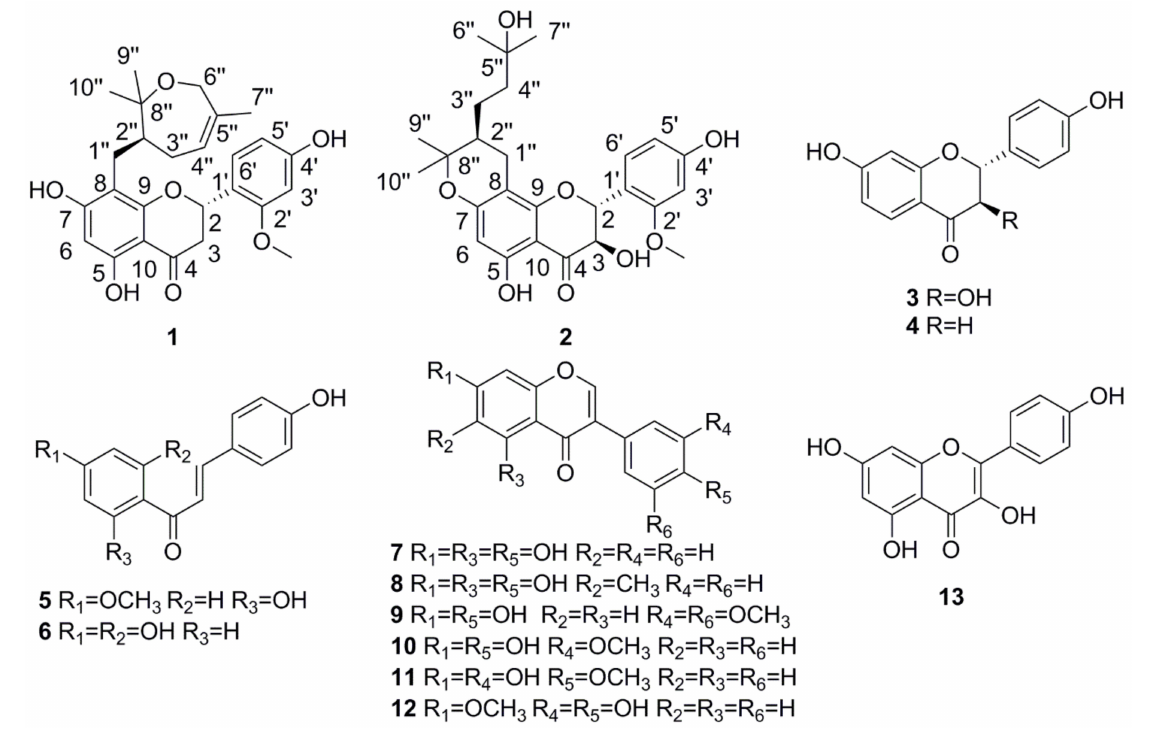
Figure 1. The structures of compounds 1 – 13